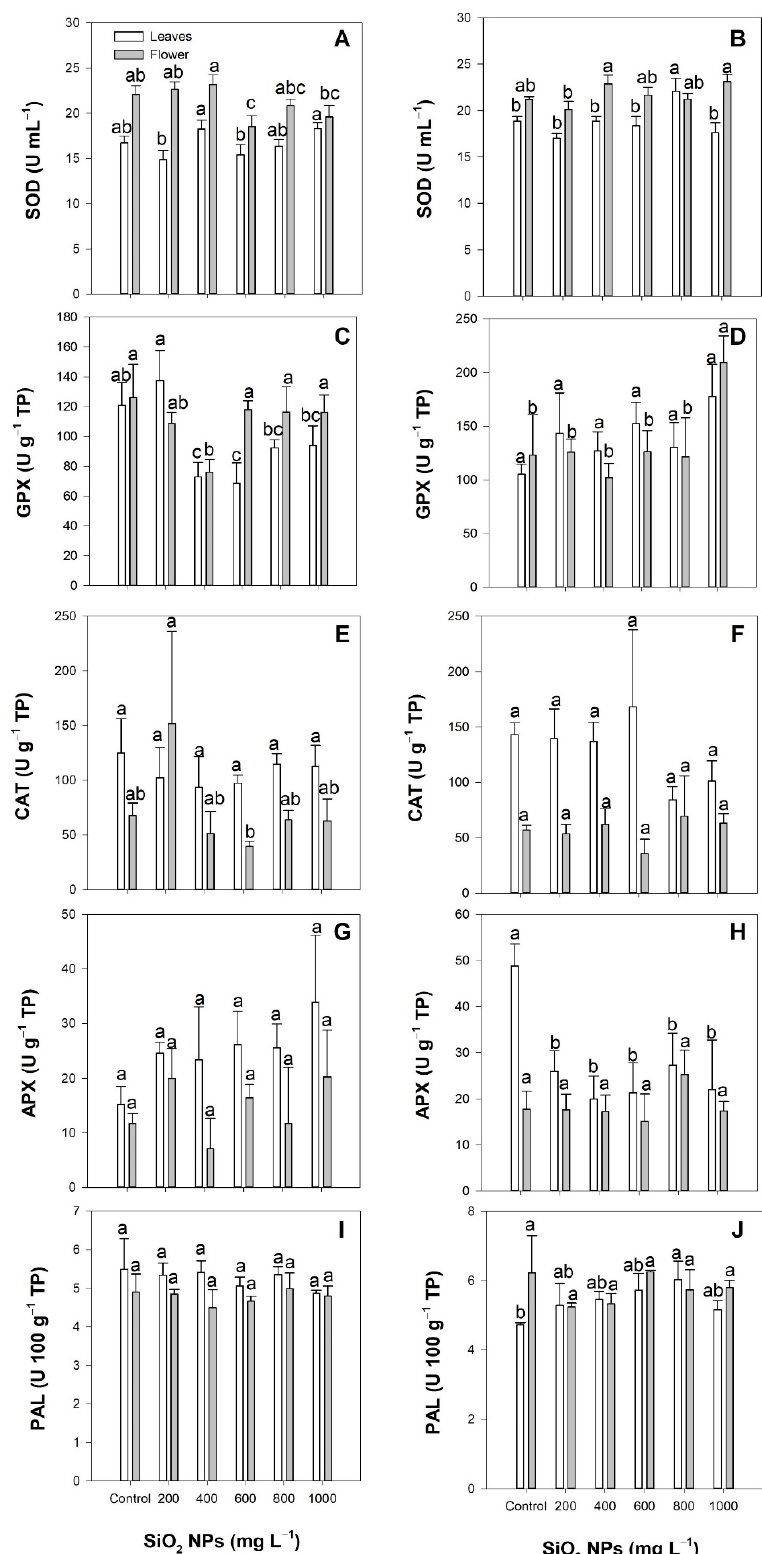
Figure 4. Effect of the application of SiO 2 NPs via the soil method ( A , C , E , G , I ) and the foliar method ( B , D , F , H , J ) on the activity of the antioxidant enzymes SOD ( A , B ), GPX ( C , D ), CAT ( E , F ), APX ( G , H ), and PAL ( I , J ) in Lilium . Different letters indicate significant differences according to Fisher’s least significant difference test ( p ≤